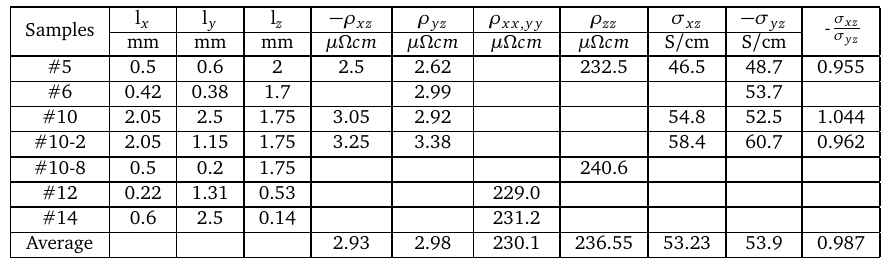
Table S1: Anisotropy of the anomalous Hall effect in different samples at 300 K. Samples